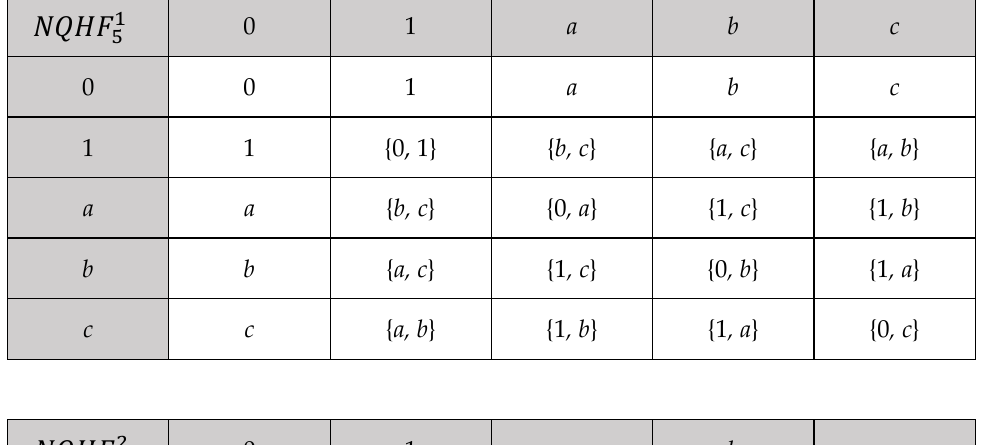
Table 13. The Cayley tables of the additive canonical hypergroups of the non-quotient hyperfields whose multiplicative group is the Vierergruppe.